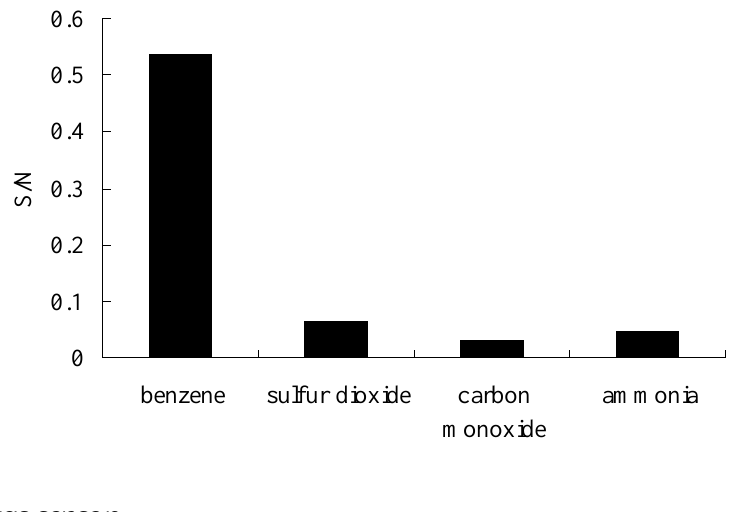
Figure 7. CTL responses of different compound on the